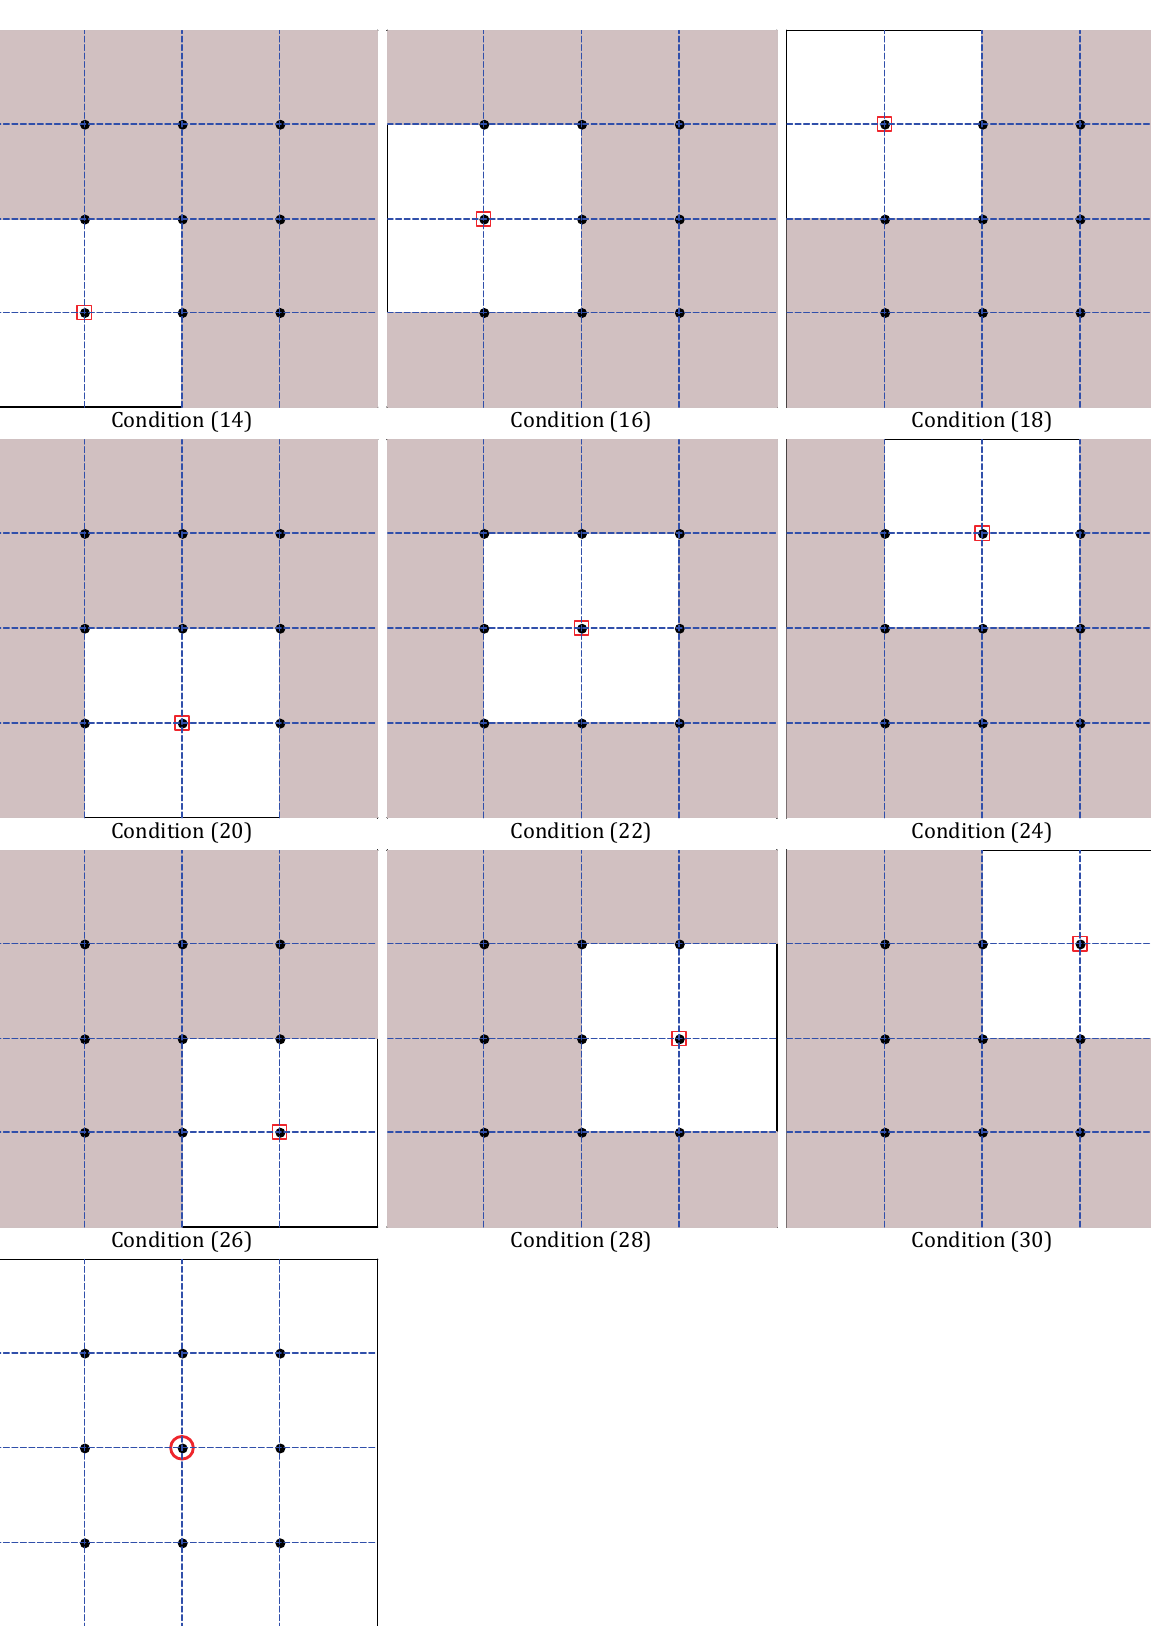
Fig. 5. The 10 possible cases and their outcomes (the area which is cut off is darkened) issued from one of conditions (14), (16), (18), (20), (22), (24), (26), (28), (30), (32), where the least value is marked by square and the maximum by (32) is marked by